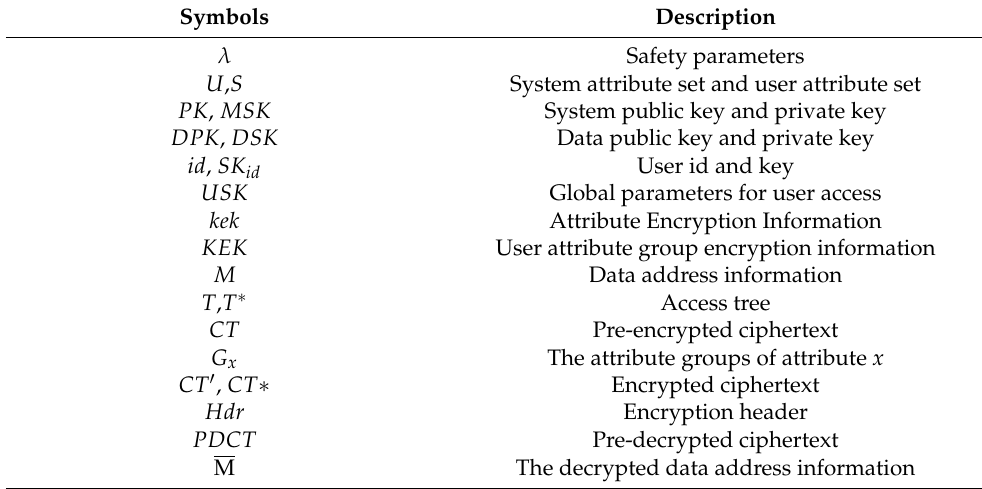
Table 1. Description of